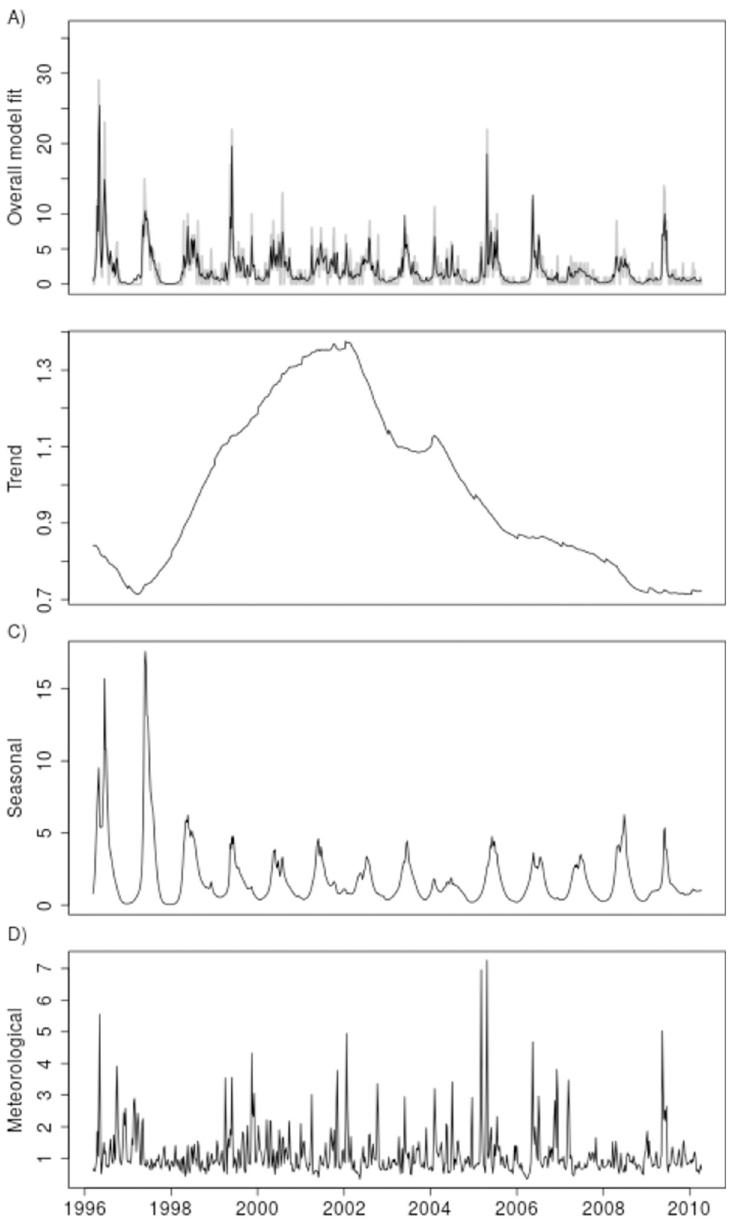
Fig 2. Panel A shows fitted weekly leptospirosis incidence (black solid line) and observed weekly laboratory confirmed leptospirosis incidence (grey solid line) and its respective decompositions into trend (panel B), seasonal (panel C) and meteorological (panel D) components, Salvador, Brazil,